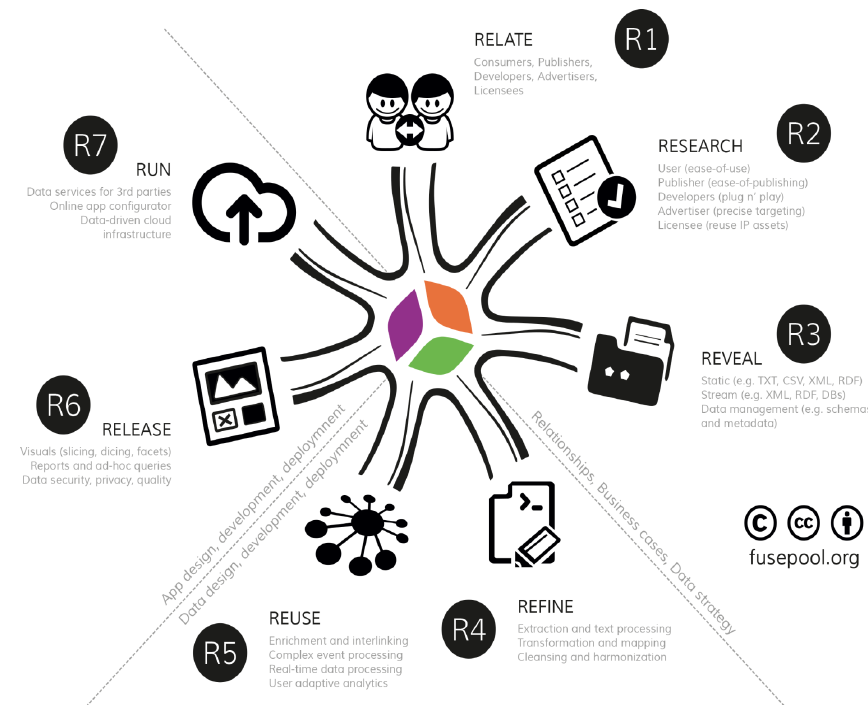
Figure 1. 7R Data Value